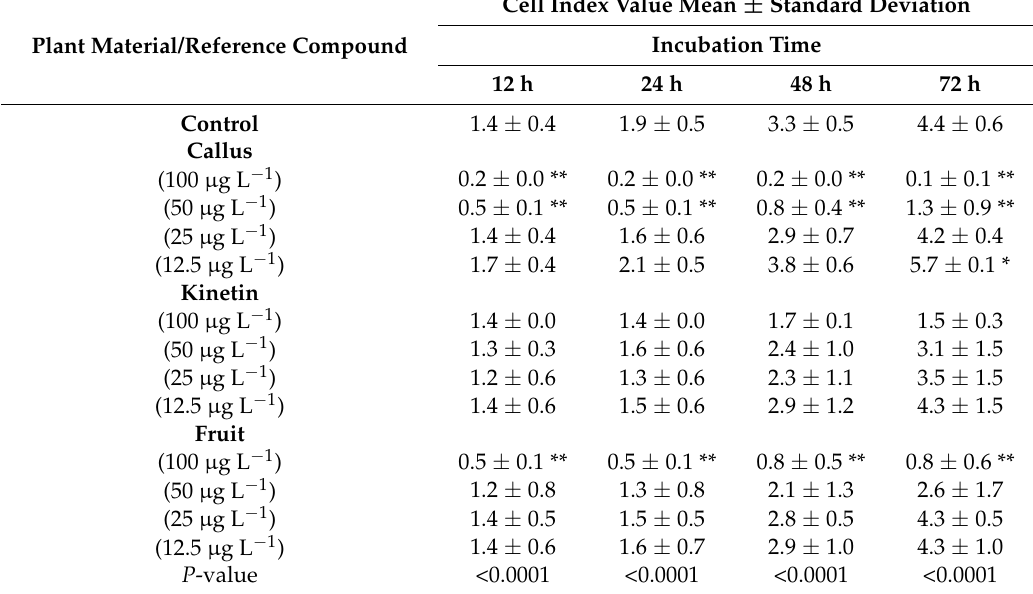
Table 6. The effect of callus extracts of Chaenomeles japonica , kinetin, and fruit extracts on the proliferation rate of CRL-2522